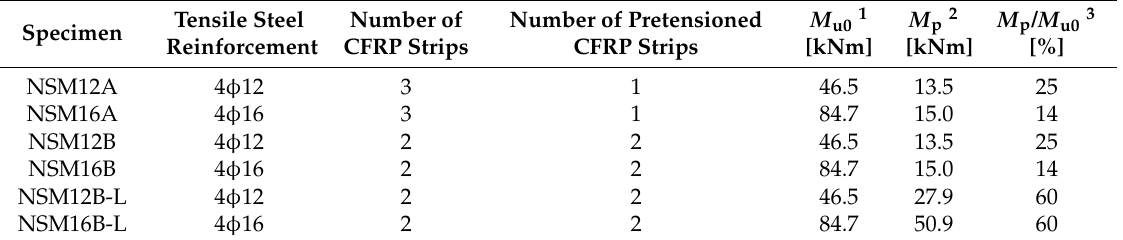
Table 1. Summary of tested beams, investigated parameters, and strengthening configuration.